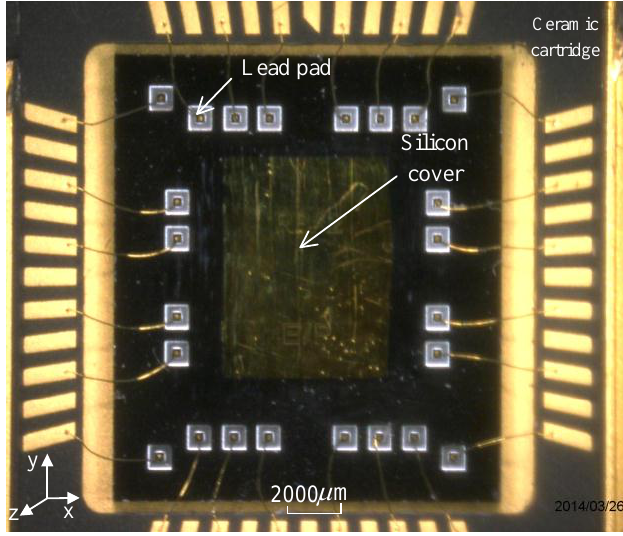
Figure 3. Photo of the SMRA wafer-level vacuum packaged die.